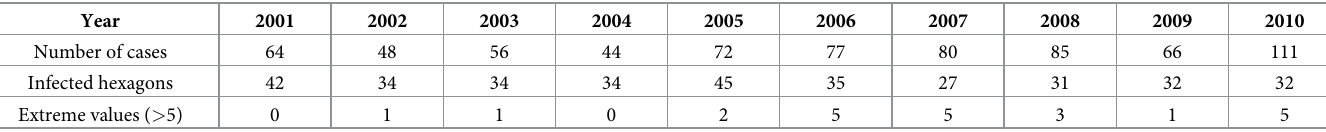
Table 1. Evolution of the number of cases.